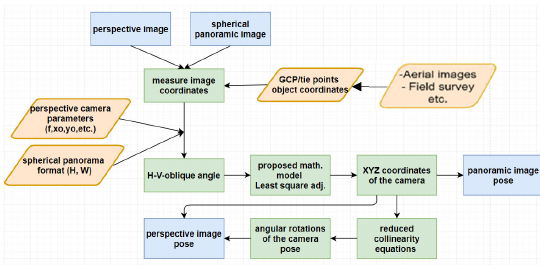
Figure 5. Oblique angular-based resection workflow.